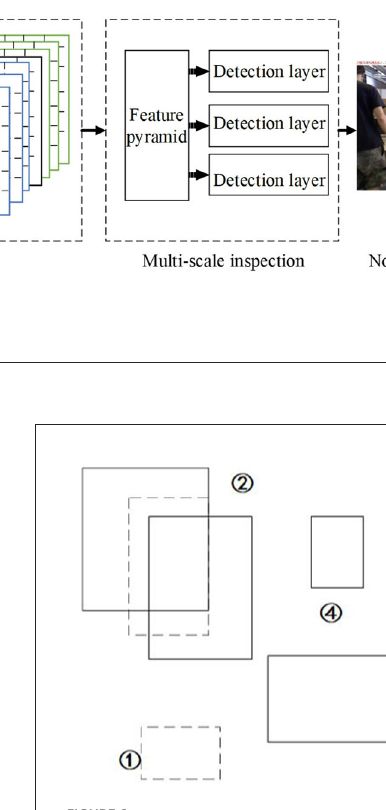
FIGURE6 Schematic diagram of dynamic area